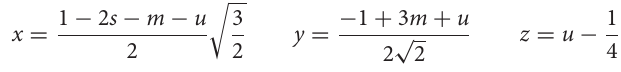
while this work has identified the adaptive significance of the red